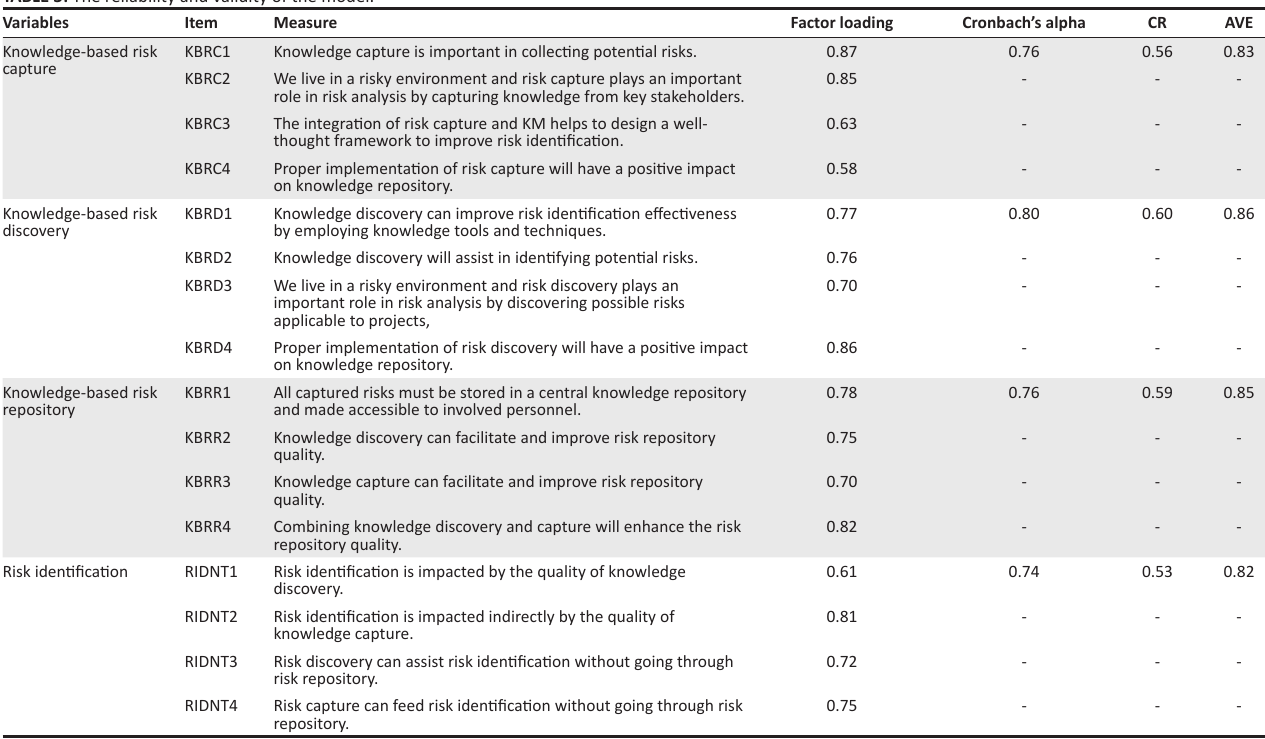
TABLE 3: The reliability and validity of the model. Variables